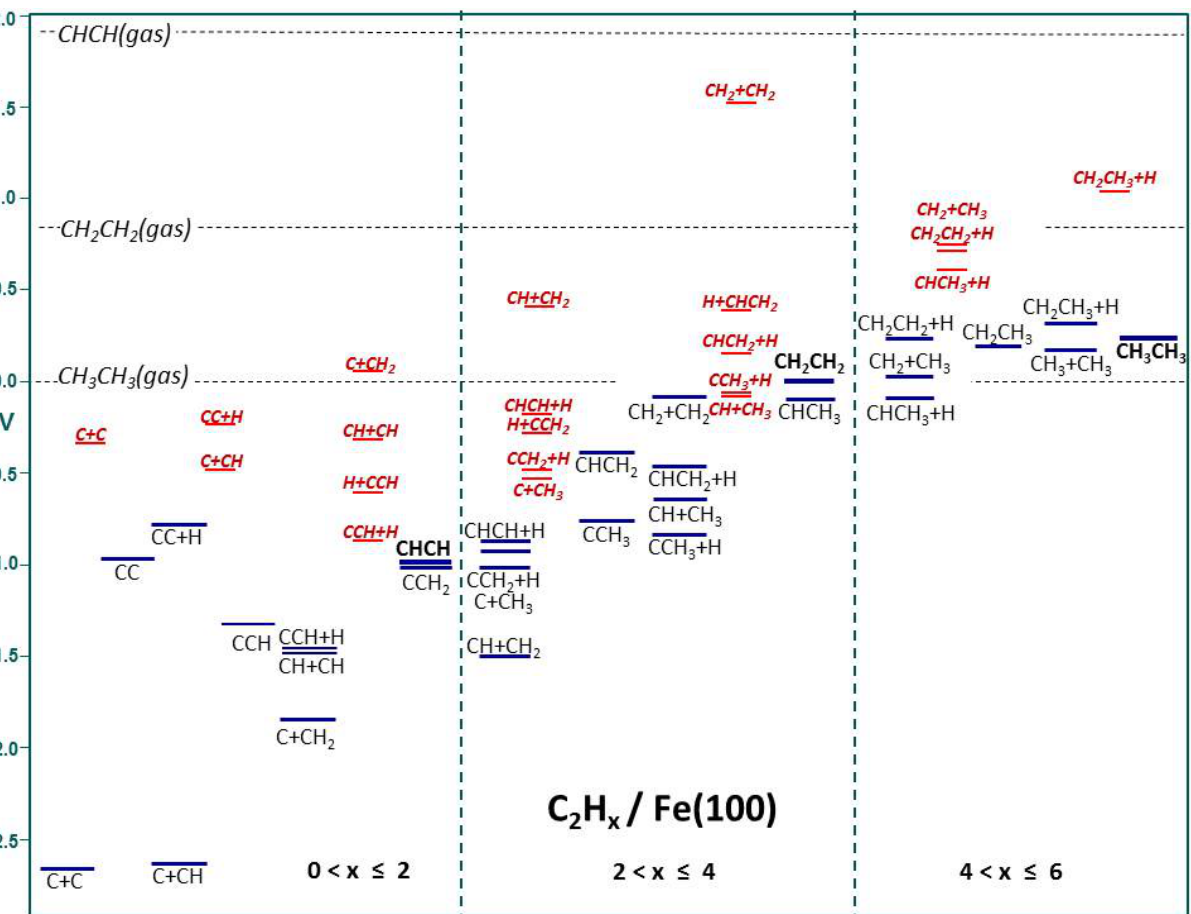
Figure 2. Compilation of chemical potential profiles of C are indicated in red. The x -axis shows the systematic H-addition while the y -axis expresses energy in electronvolts